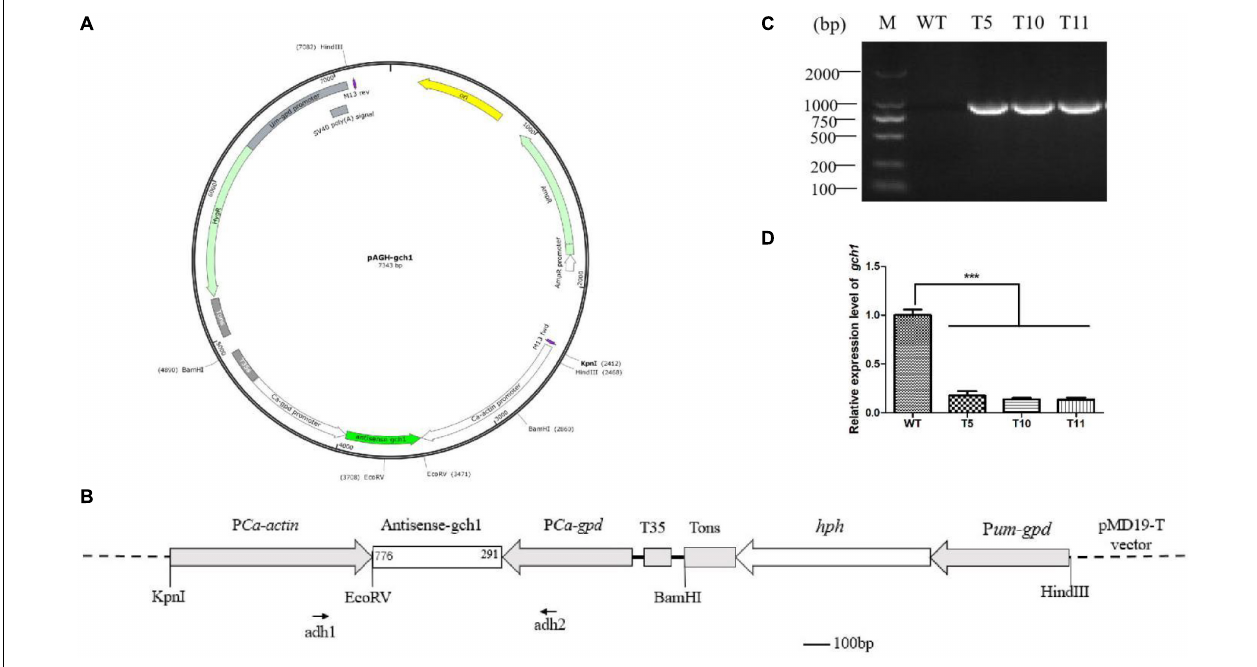
FIGURE 2 | (A) Structure of the pAGH-gch1 plasmid. (B) Diagram of the RNAi vector construction. The antisense fragment of cagch1 was inserted in the site between the promoters actin and gpd . The primer pair of adh1 and adh2 was used for the verification of the transformants. (C) The verification of transformants. (D) The expression analysis of cagch1 . Asterisks (***) indicate the data that differed significantly based on p < 0.0001 ( t -test) as the significance threshold.